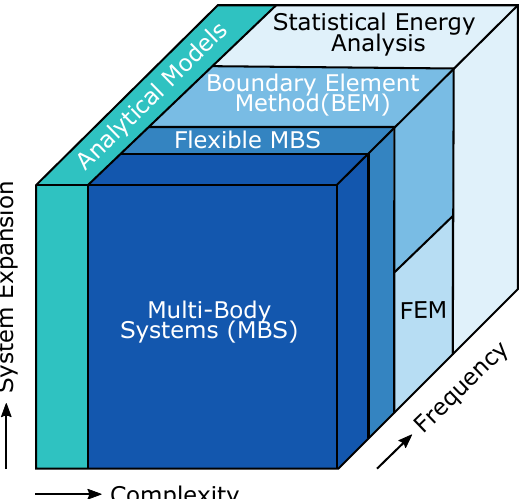
Figure 1. Common simulation approaches and their typical areas of application according to